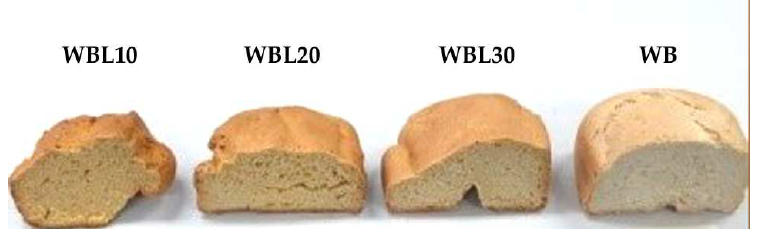
Figure 2. Final products. WB, wheat bread; WBL10, lupin/wheat bread 10%; WBL20, lupin/wheat bread 20%; WBL30, lupin/wheat bread 30%.